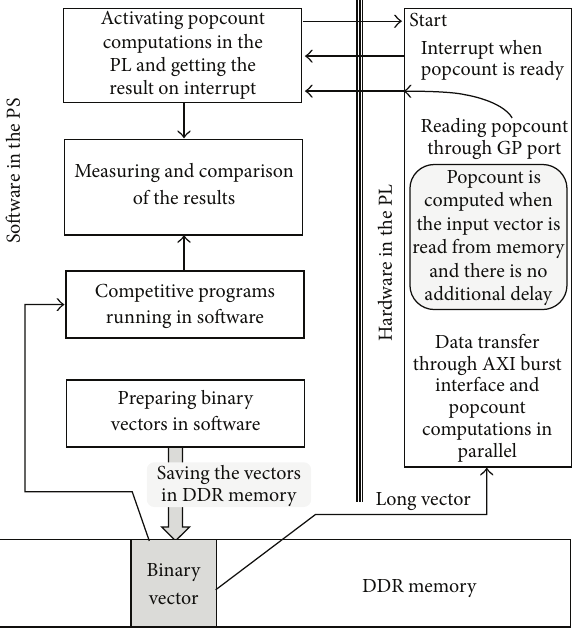
Figure 6: General structure of the